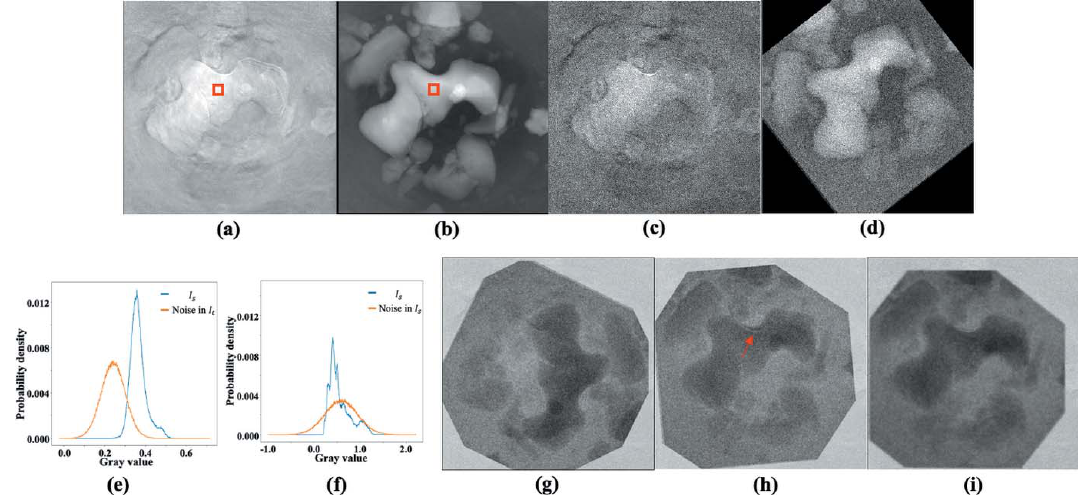
Figure 5 Images used in experiment 3 and results. Panels ( a ) and ( b ) show the original images for the synthesizing target and source images in ( c ) and ( d ), respectively. ( e ) Histograms of ( a ) and the additive noise in ( c ). ( f ) Histograms of ( b ) and the additive noise in ( d ). ( g )–( i ) Difference images between ( c ) and the registered images with FPC, SSD and